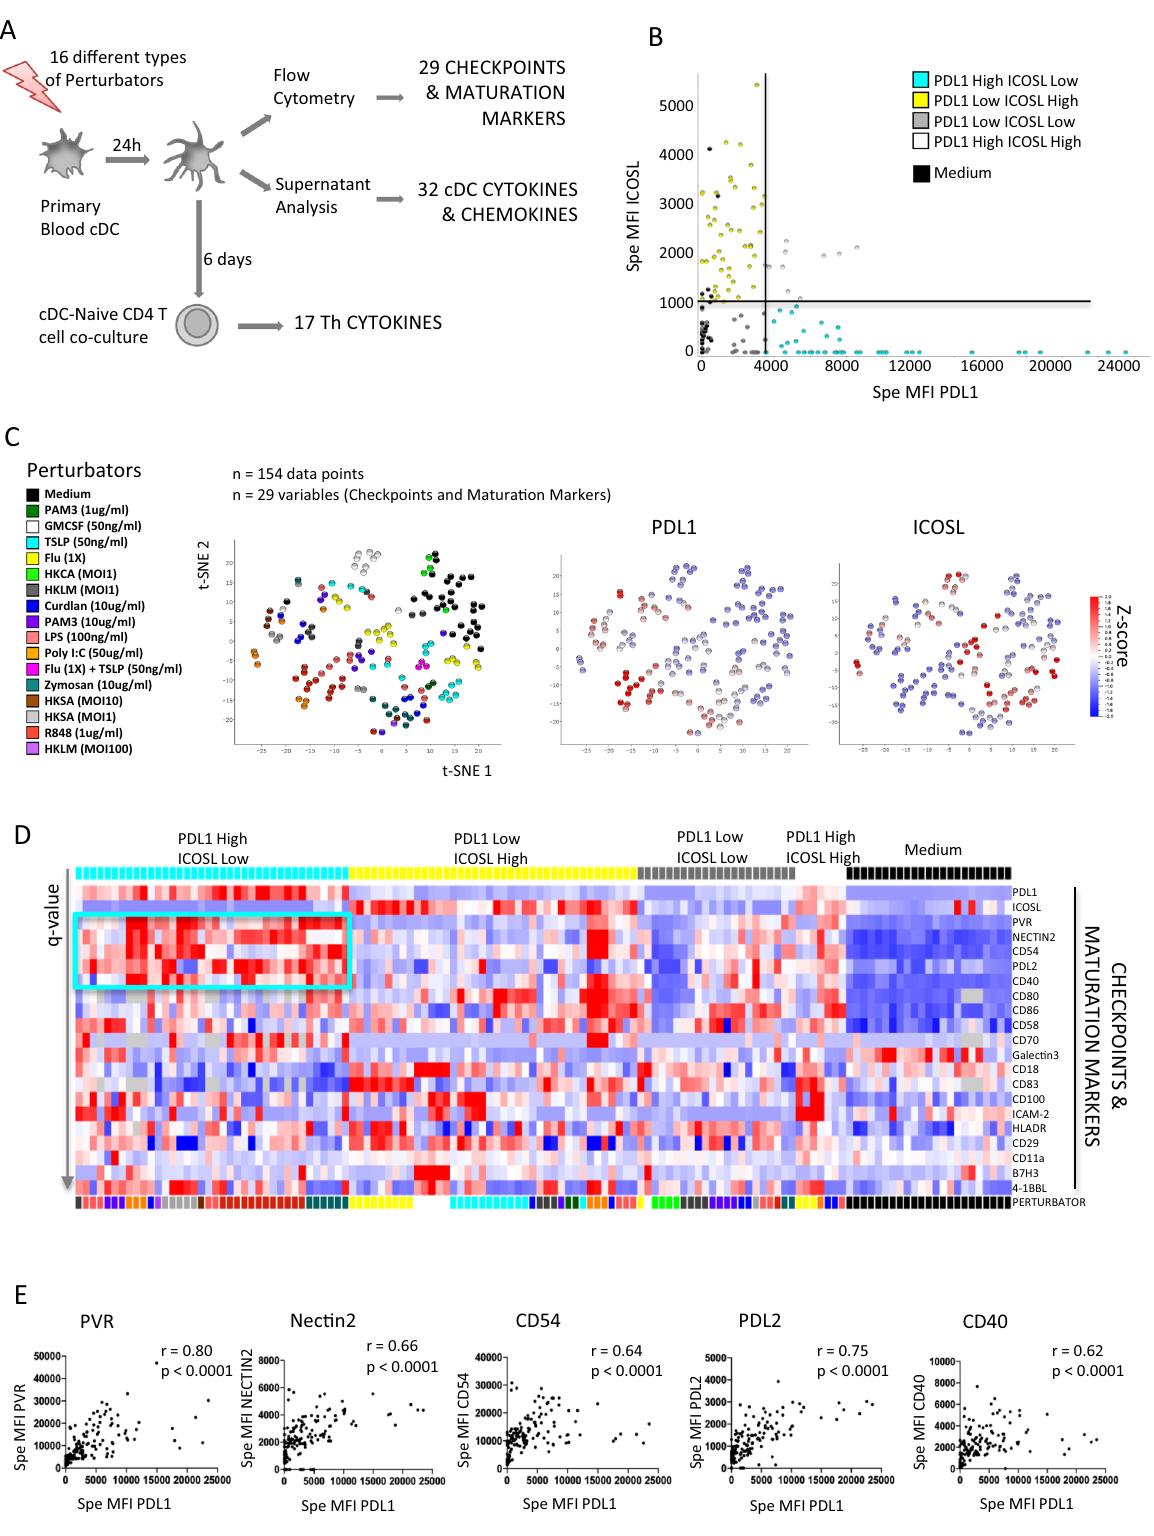
discriminating the various cDC phenotypes observed in vitro (Fig. 2C). We observed that PD-L1 high cells clustered together, and were distinct from ICOSL high cell clusters, and from PD- L1 low ICOSL low cluster, the latter including most Medium conditions (Fig. 2C). The cDC perturbators inducing a majority of PD-L1 high ICOSL low cDC were R848, Zymosan, heat-killed Staphylococcus and heat-killed Listeria